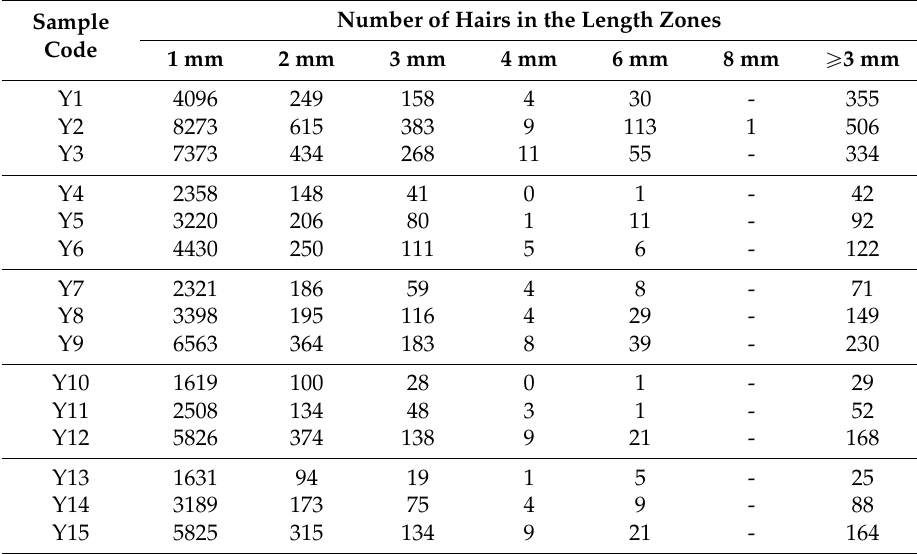
Table 2. Hairiness length and number distribution of BC, PC and BPC complex